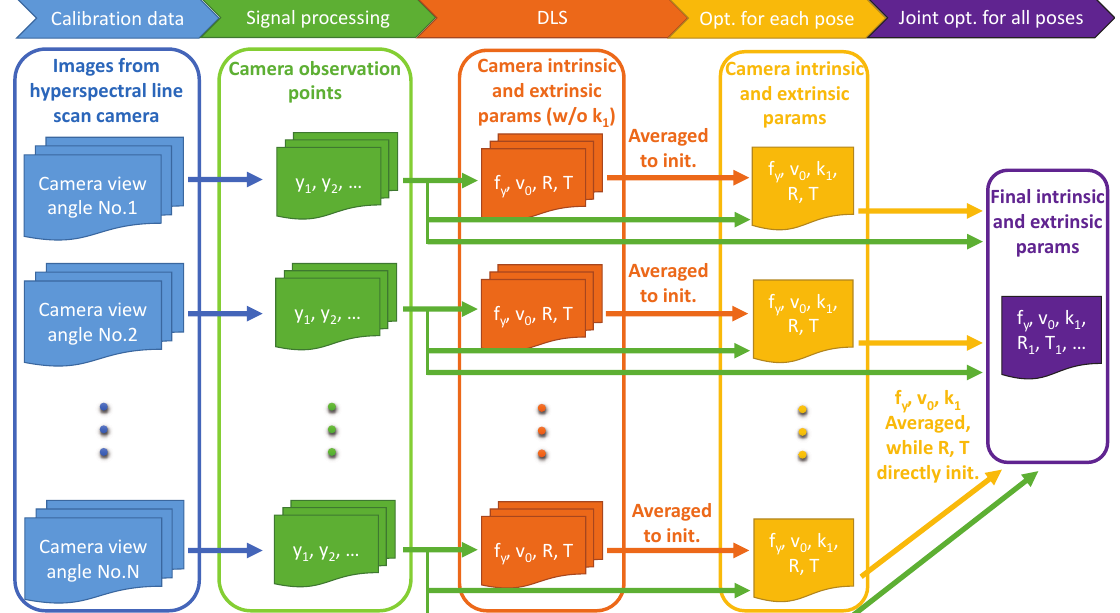
Figure 2. Structure of the proposed method. In the first step, multiple images of the calibration target are gathered at different camera view angles. A signal processing step (Section 3.3) is used to locate calibration feature points in each hyperspectral image. In the next step (Section 3.4), the DLS is used on each set of calibration feature points to estimate the intrinsic and extrinsic parameters of the line-scan camera, excluding radial distortion. At each camera view angle, the DLS estimates are averaged and used as the starting location for a nonlinear least squares optimization of the camera intrinsic and extrinsic parameters including radial distortion (Section 3.5). This is done by minimizing the re-projection errors of the calibration feature points at each camera view angle. A final nonlinear least squares optimization is performed to minimize the re-projection errors of all calibration feature points jointly (Section 3.6). The joint optimisation is initialised using the average intrinsic parameters from all view angles and all extrinsic parameters from the previous